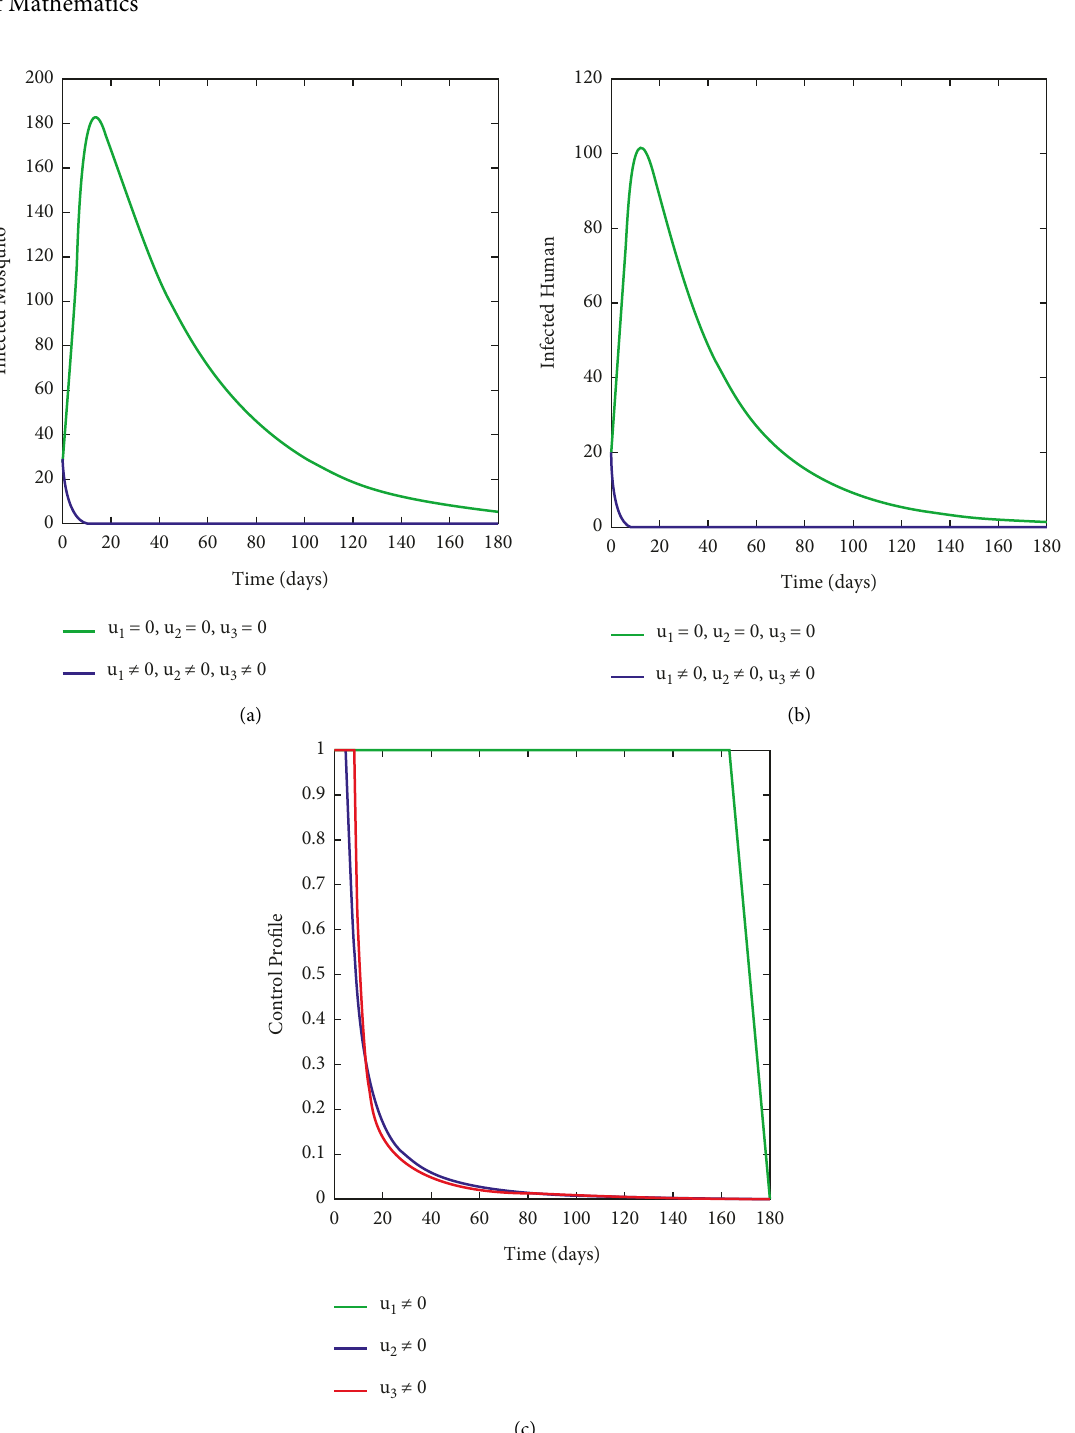
), treatment ( u ), and insecticides spray ( u 1 2